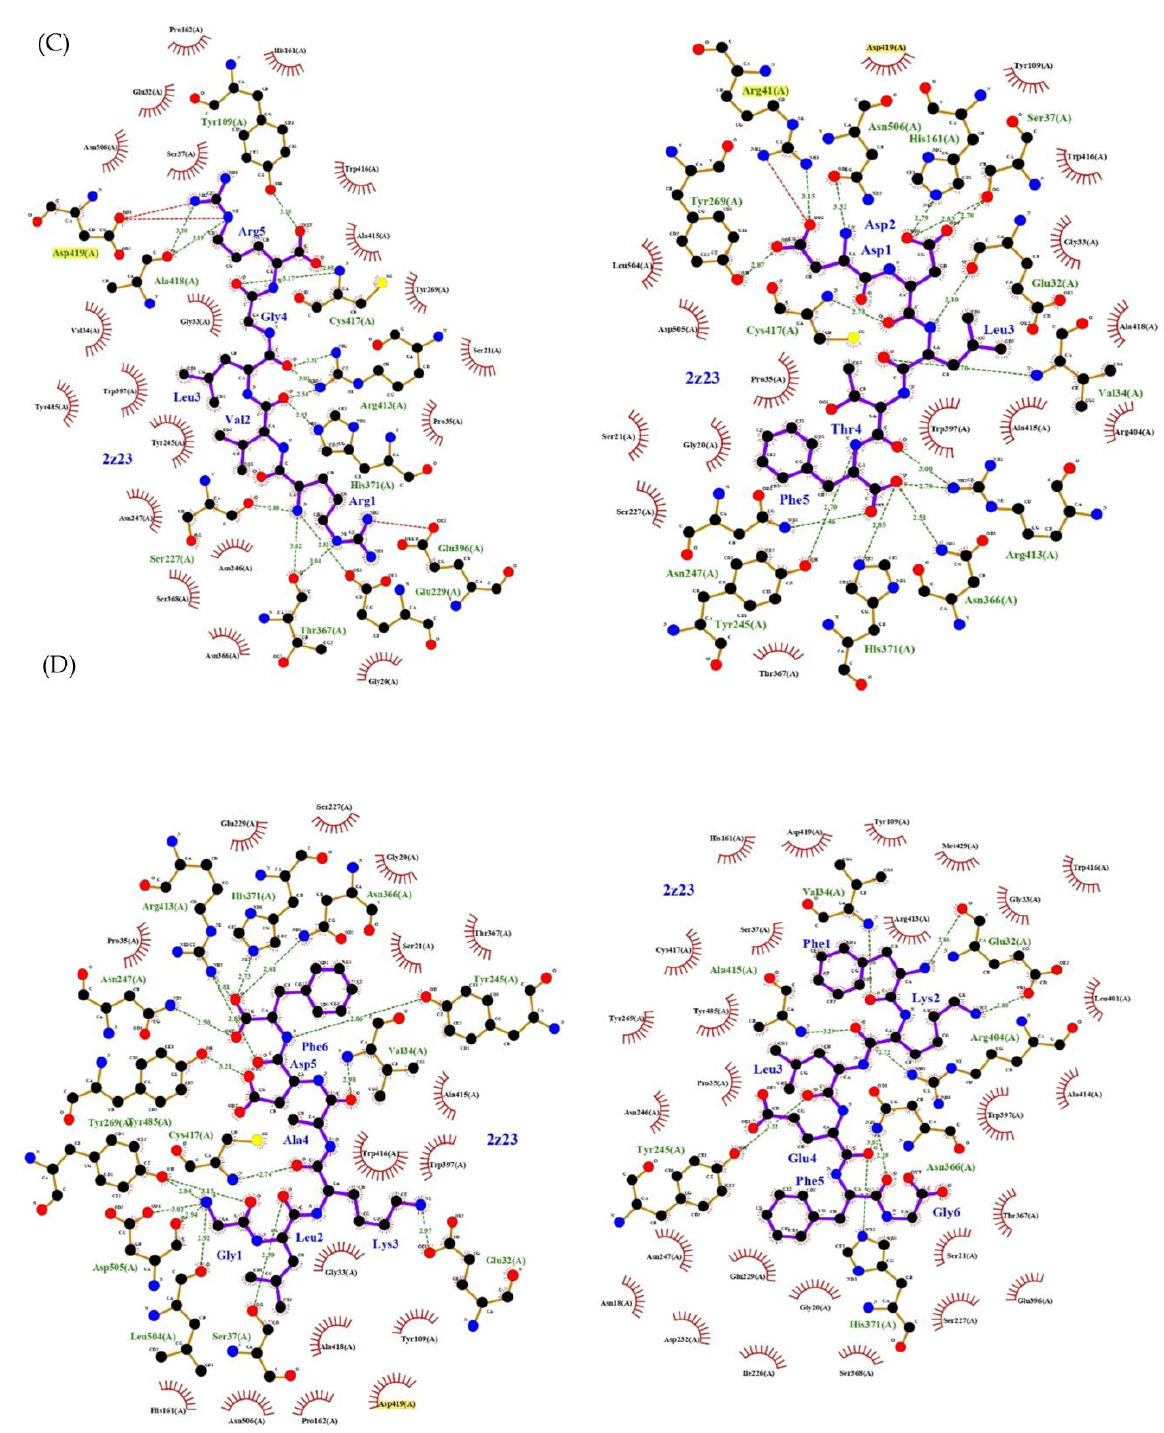
Figure 4. Two-dimensional diagrams, generated in LigPlot from the results of the molecular docking performed with Autodoock Vina, of the interactions of the two best ligands extracted from the structure of ( A ) the Mal12 hydrolase, ( B ) LDH lactate dehydrogenase, ( C ) Eco RI nuclease and ( D ) THG lipase. Hydrogen bonds formed between the amino acids of the protein (yellow) and its ligand (purple) can be seen as green dotted lines; salt bridges are depicted as red dotted lines; and hydrophobic interactions with the amino acid are delimited by a semicircle with red tabs. The distance between the links was calculated with LigProt.